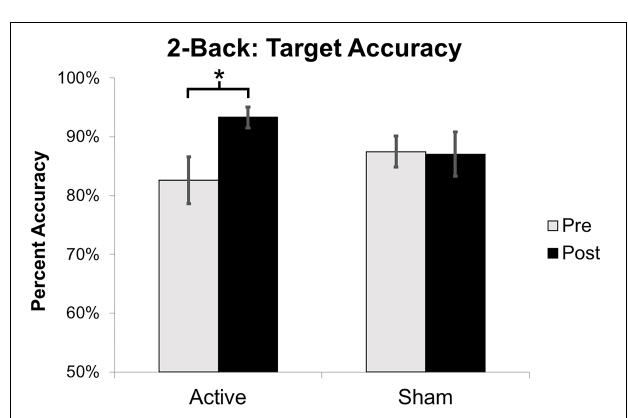
FIGURE 4 | Mean functional connectivity β values ( ± standard error) for 2-Back over rest at baseline and post-intervention from left dorsolateral prefrontal cortex (DLPFC) to right inferior parietal cortex (IPL), ∗ p -FDR < 0.05 (LH = left hemisphere; RH = right hemisphere).